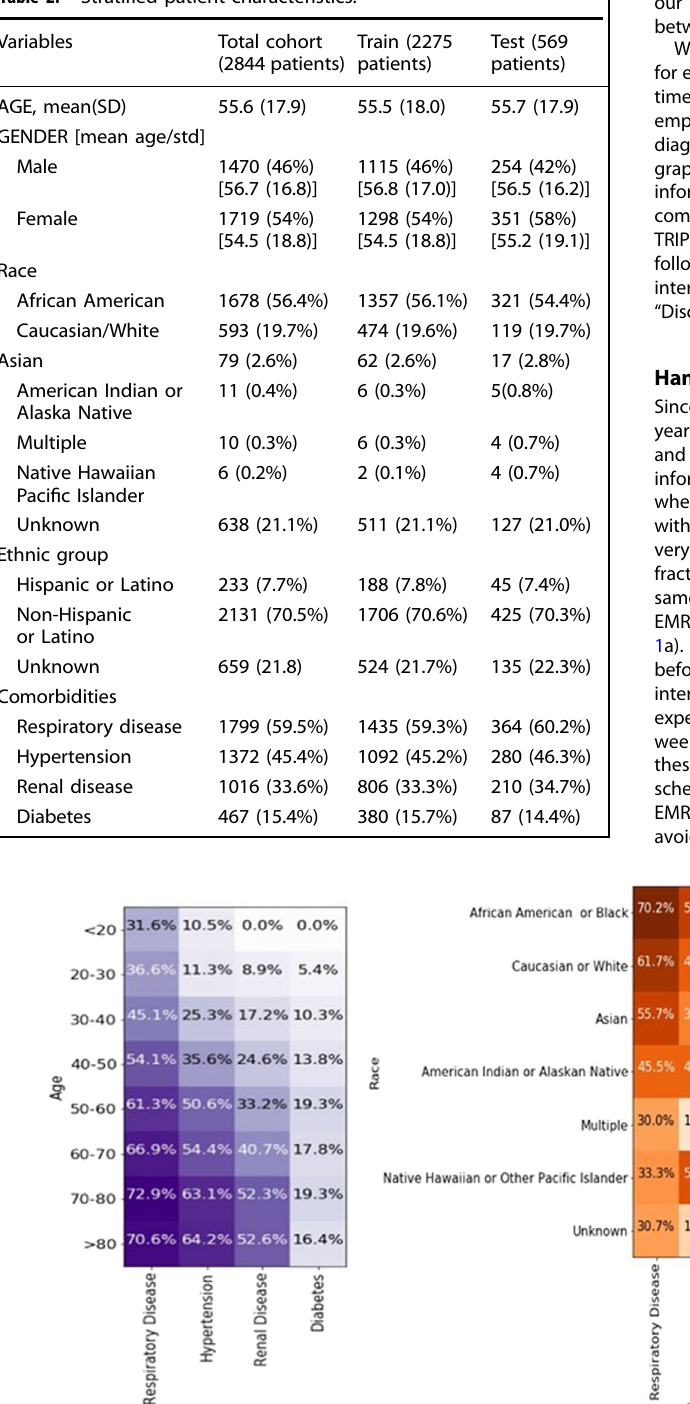
Table 2. Strati fi ed patient characteristics.